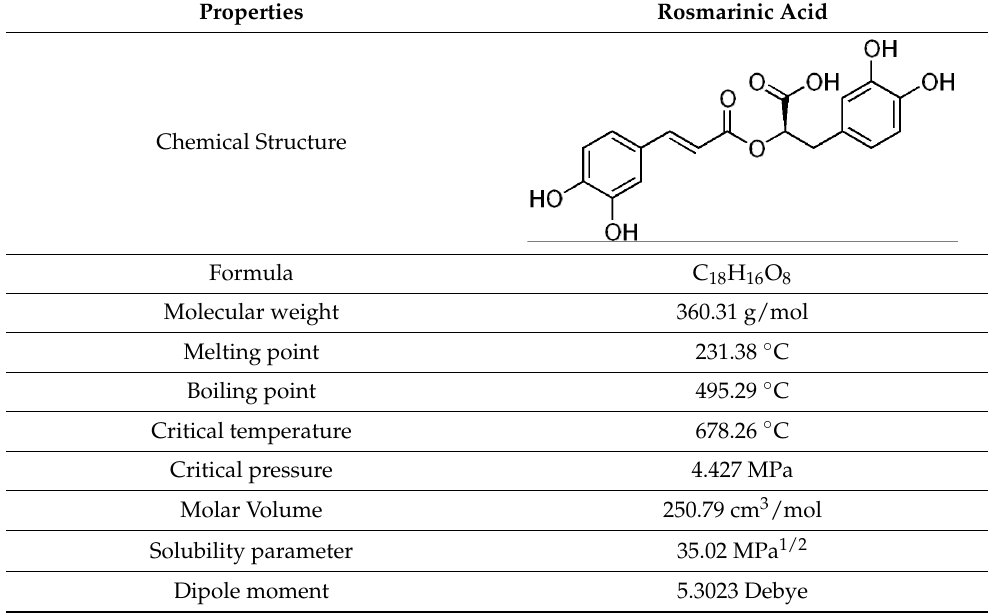
Table 1. Properties of rosmarinic acid.